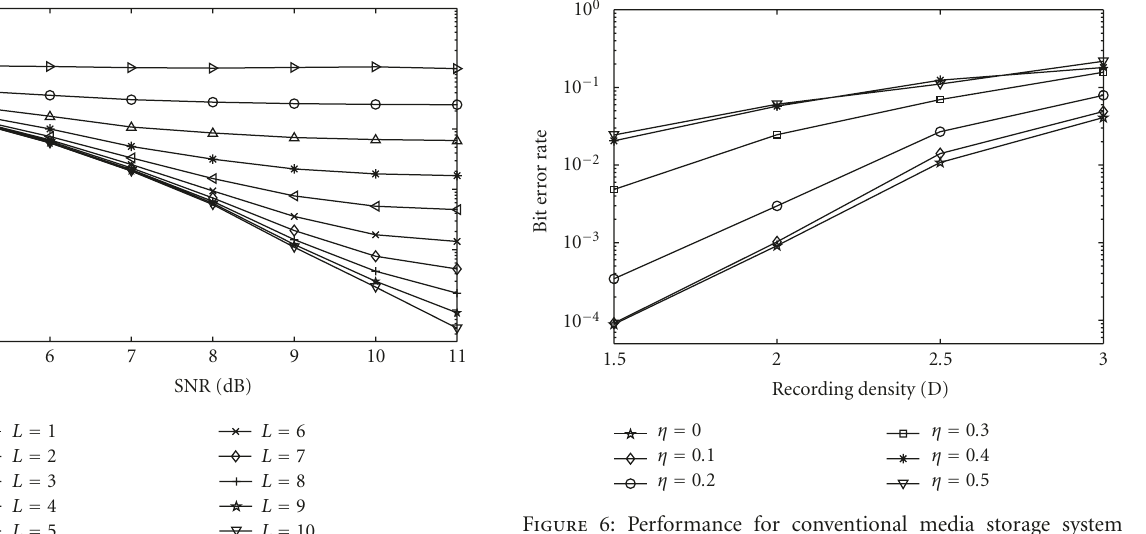
Figure 6: Performance for conventional media storage system (Lorentzian